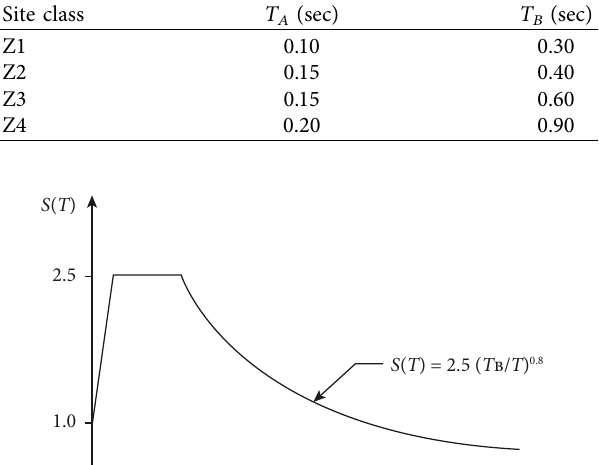
Figure 4: Spectrum